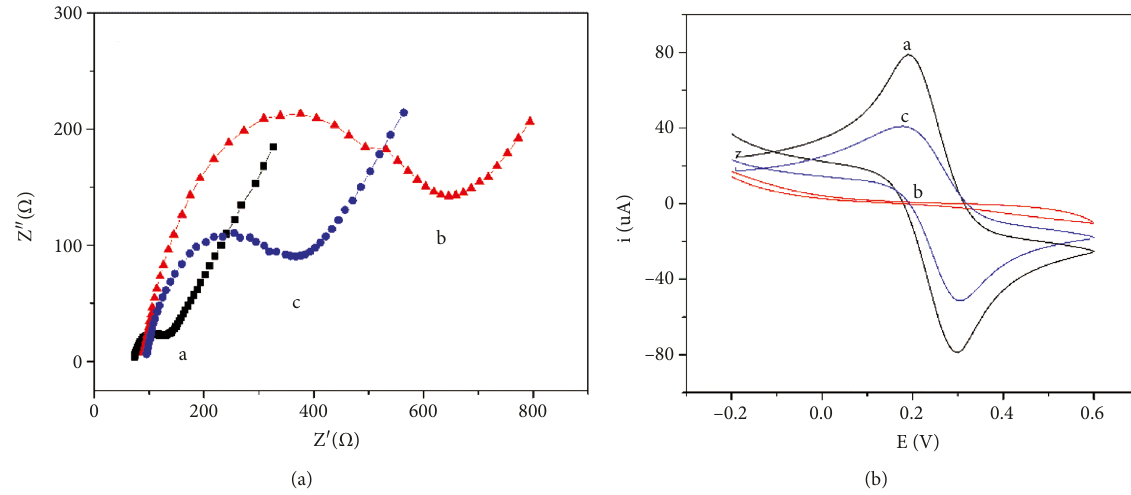
Figure 4: Electrochemical characteristic curves measured with impedance spectroscopy (a) and cyclic voltammetry (b) for bare GPE (A), GPE/COFTFPB-TZT (B), and GPE/COF TFPB-TZT /Hg 2+ (C) in a media solution containing 2.0mmol/L K 3 Fe (CN) 6 and 0.2mol/L Na 2 SO 4 .